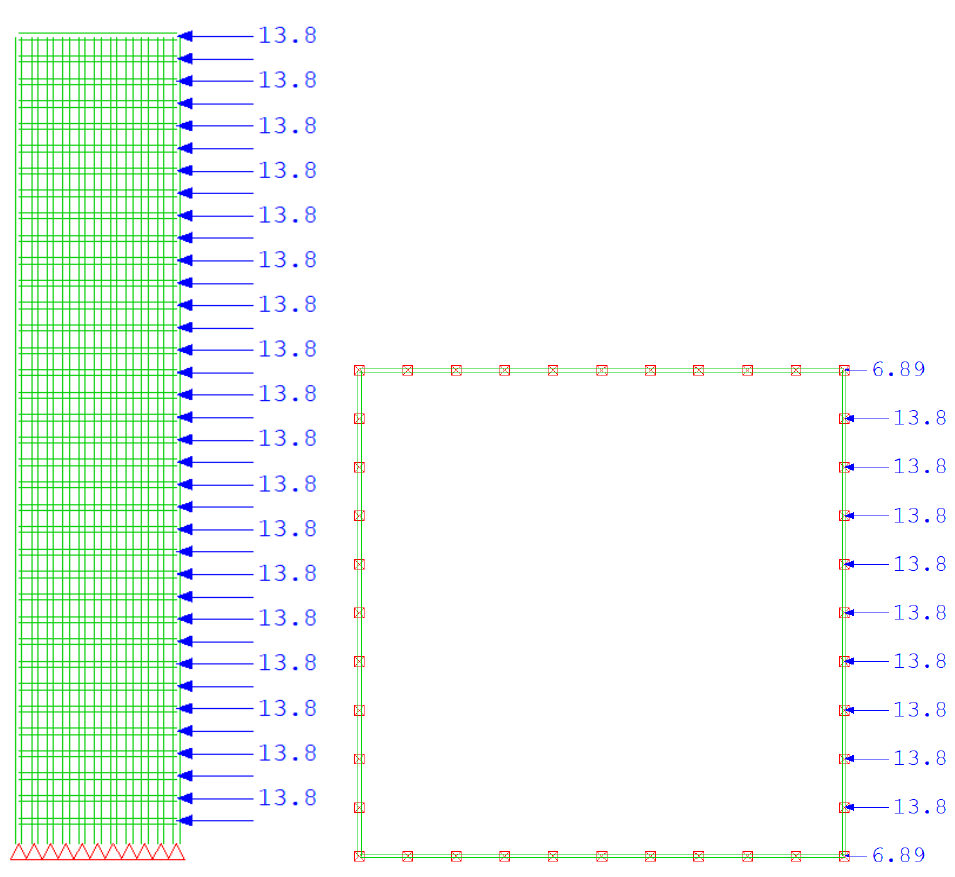
Figure 6. The display of horizontal load distribution (in kN).